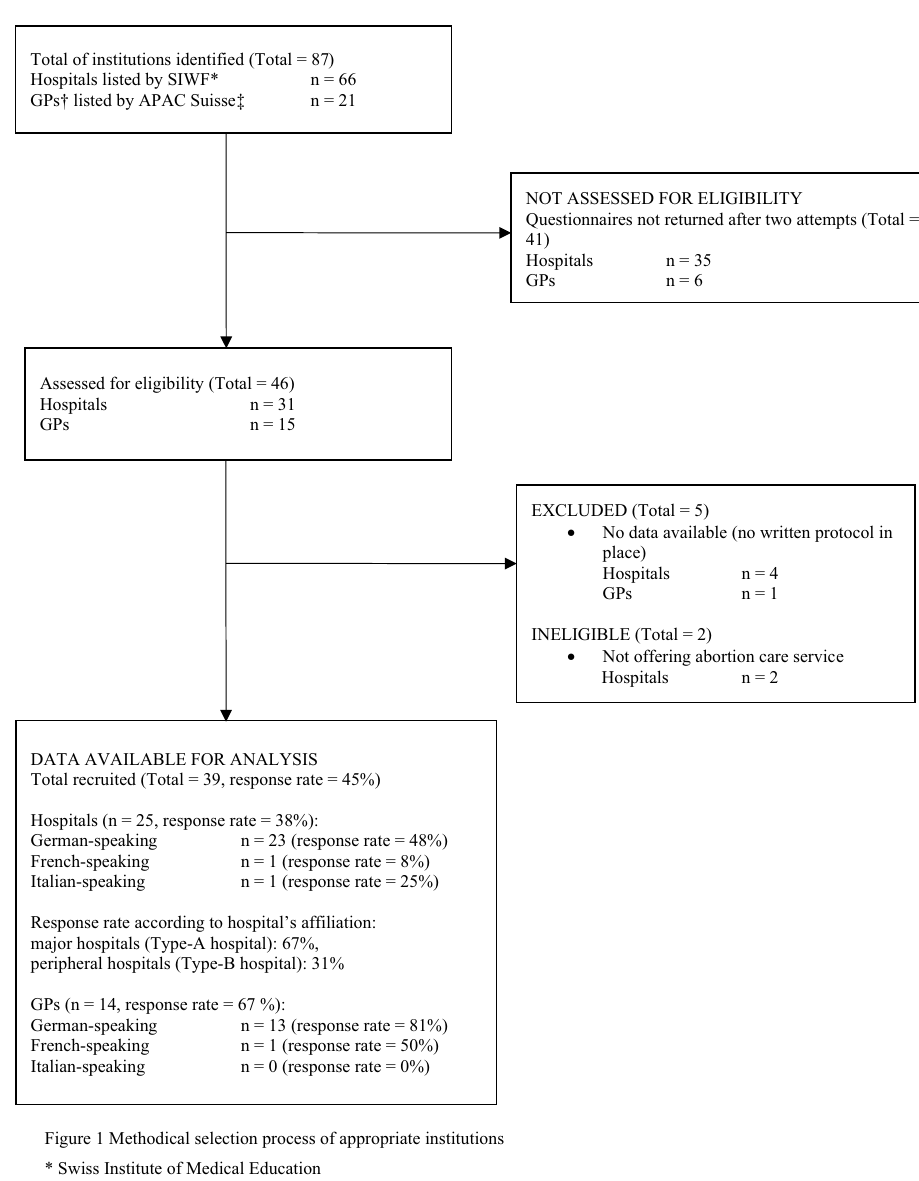
Figure 1. Study flow chart—Nationwide survey. Methodical selection process of appropriate institutions. *Swiss Institute of Medical Education. † General Practitioners. ‡ Swiss Working Group for Abortion and